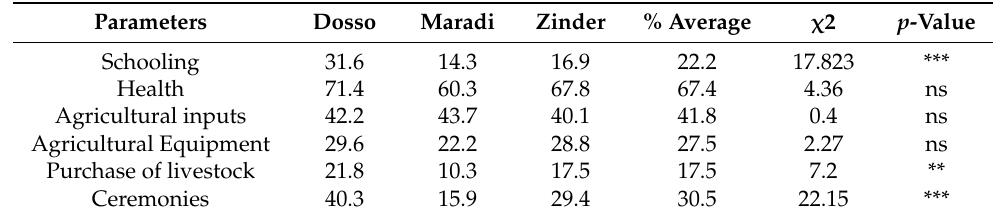
Table 7. Farmer’ expenditure of revenues generated by sales of grain stored using PICS Bags in Dosso, Maradi, and Zinder regions of